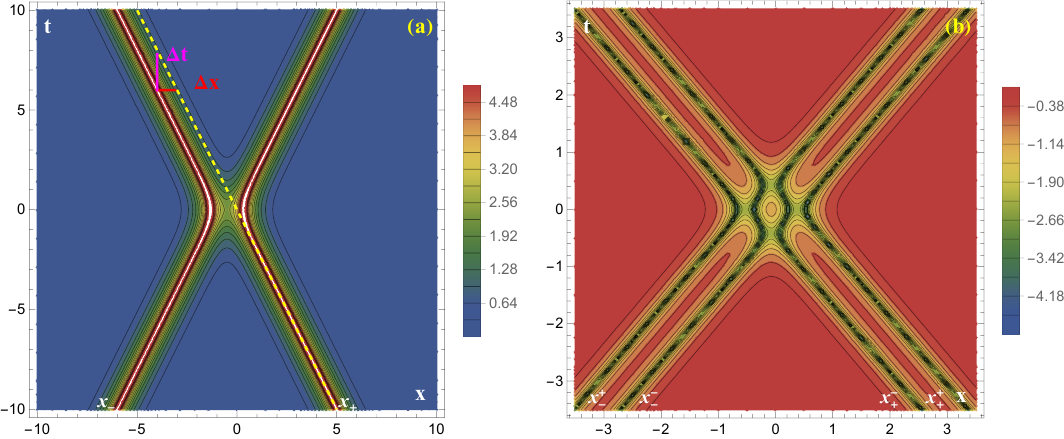
Figure 4 . Panel (a): non-regularized bright two-peakon scattering for κ = 3 , λ = 1 together with a bright one peakon (dashed yellow line). The one-peakon constituent within the two-peakon solution is tracked by a one-peakon solution with the same speed from the infinite past to the infinite future. The deviation between the two pathes in the future in space and time is the spatial displacement ∆ x and time-delay ∆ t , respectively. The poles x ± as identified in (3.30) are indicated. Panel (b): non-regularized dark two-double peakons scattering for κ = 0 . 5 , λ = 1 exhibiting a triple bouncing. The poles x ± as identified in (3.32) are ±